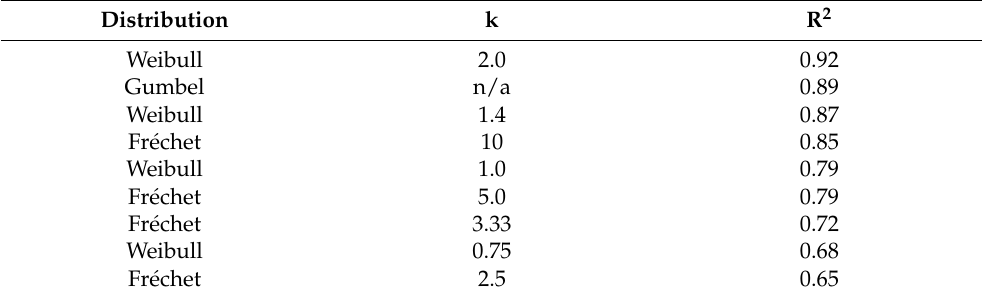
Table 5. Correlation values for each fitted distribution.